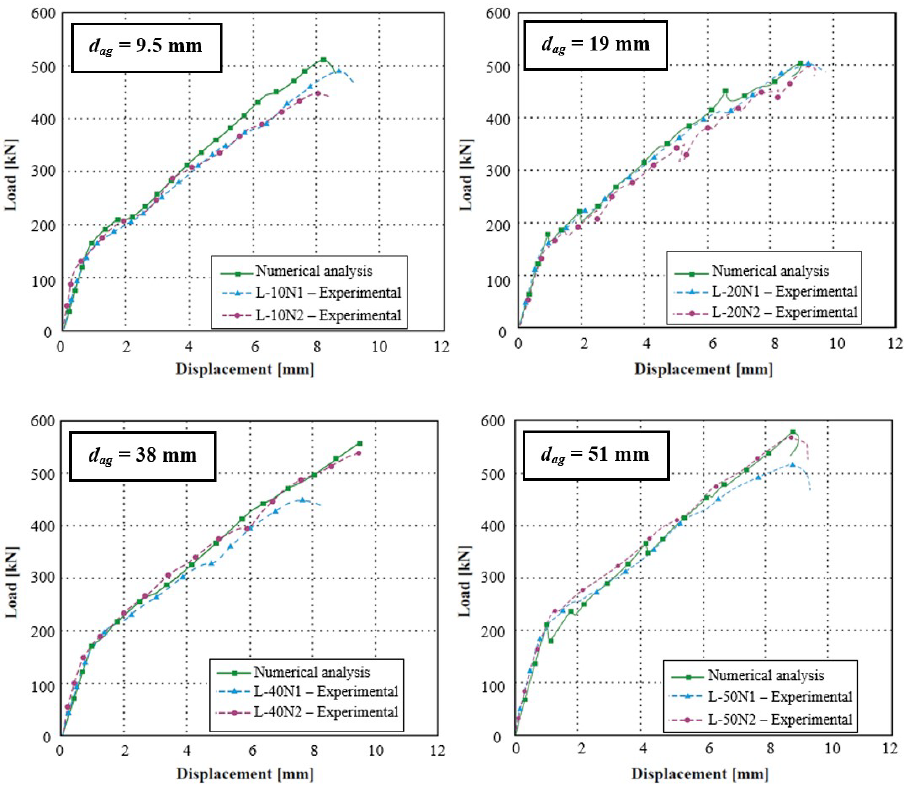
Figure 5. Load versus displacement curves for L-Series